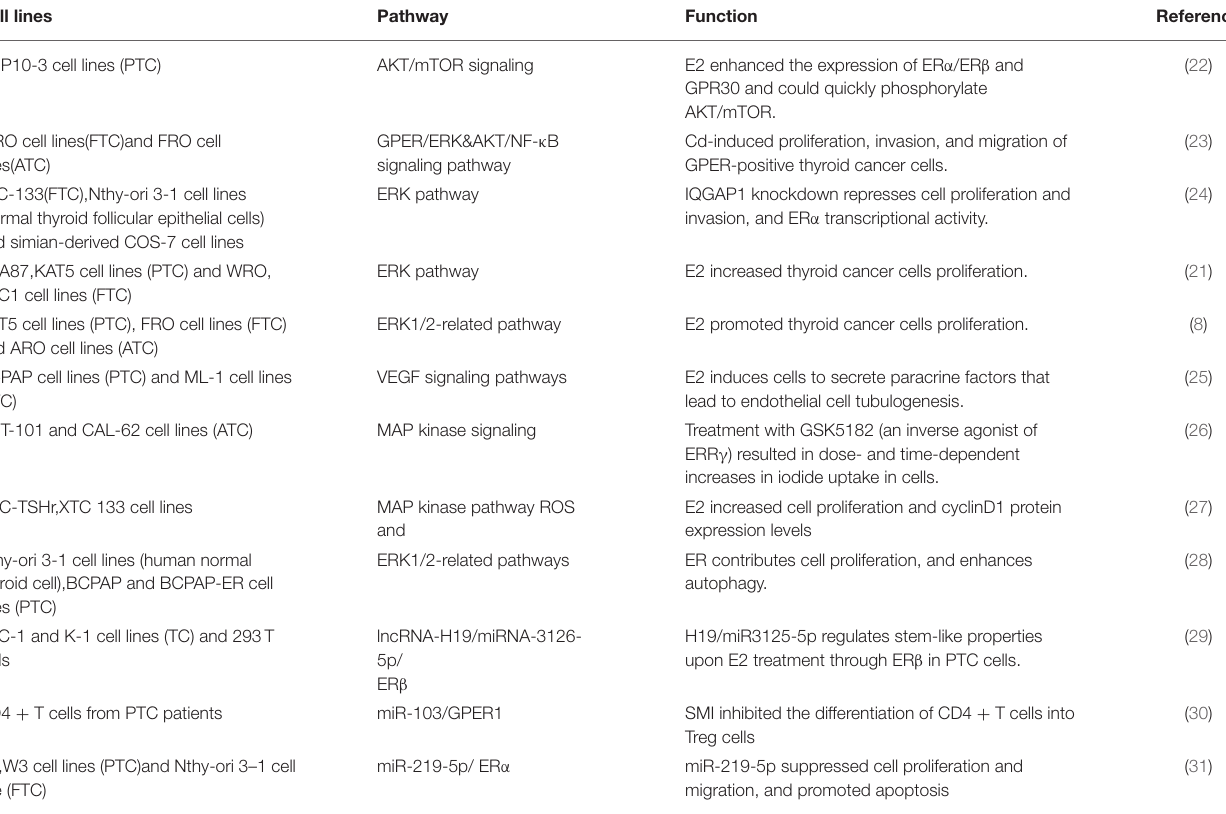
TABLE 1 | The signaling pathway of estrogen in vitro .